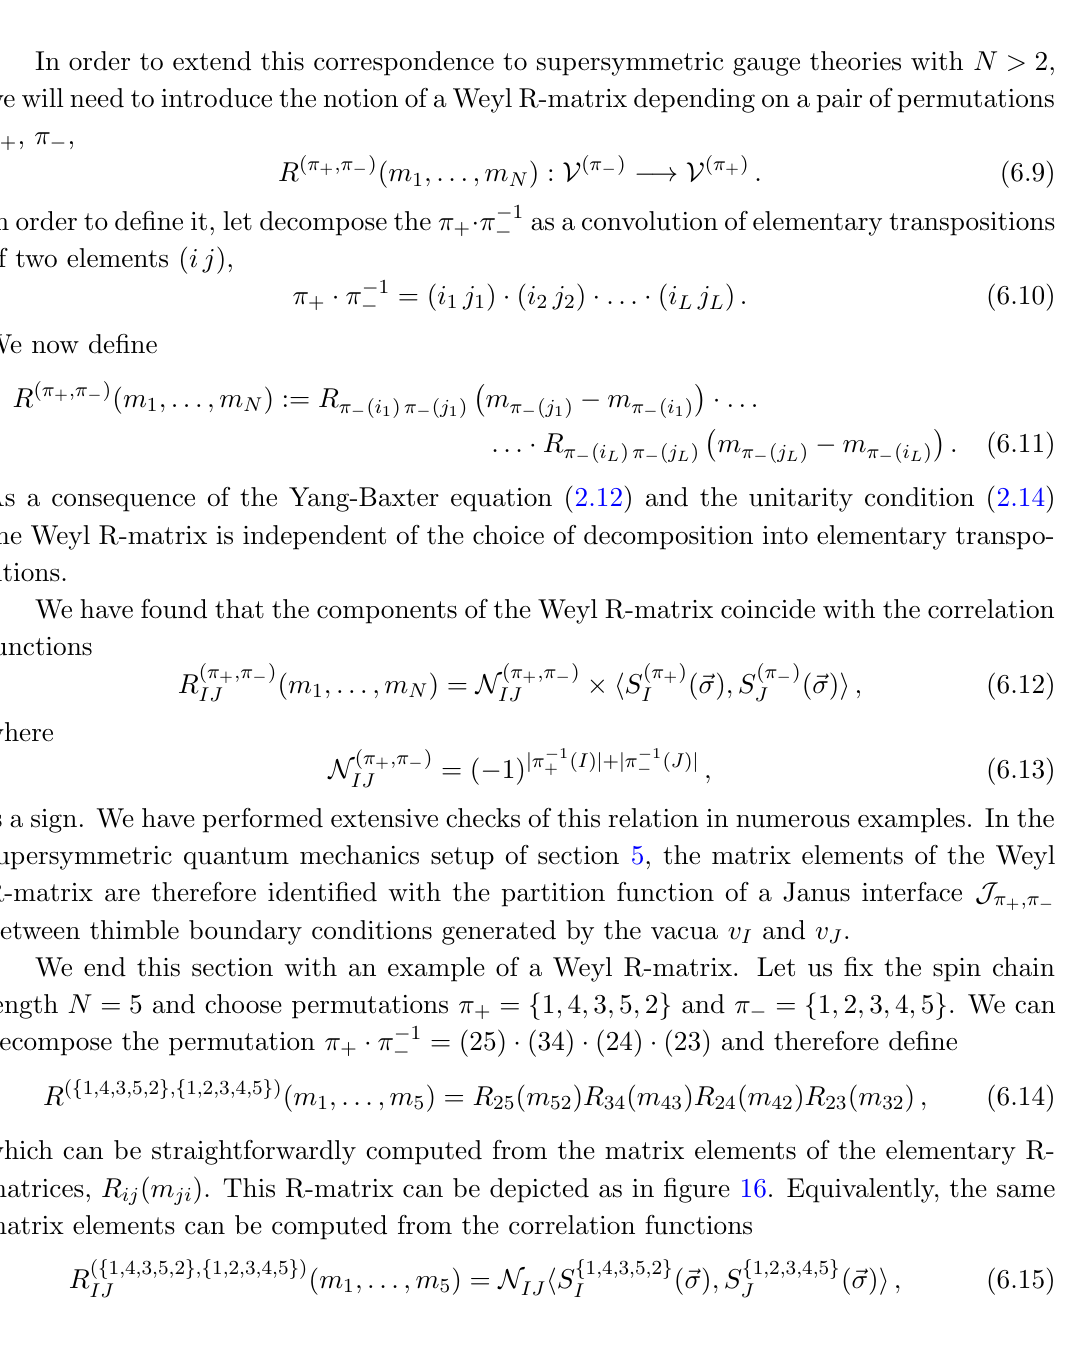
Figure 15. Graphical representation of correlation functions producing identity and R-matrix for a spin chain of length N =